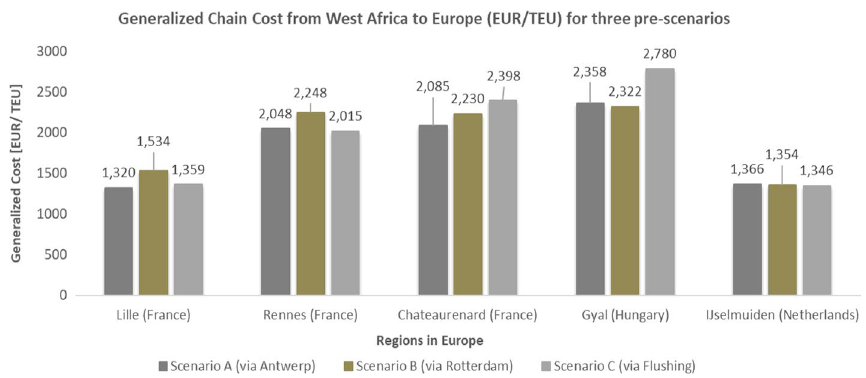
Fig. 4 Generalized chain cost—pre-scenarios A, B,